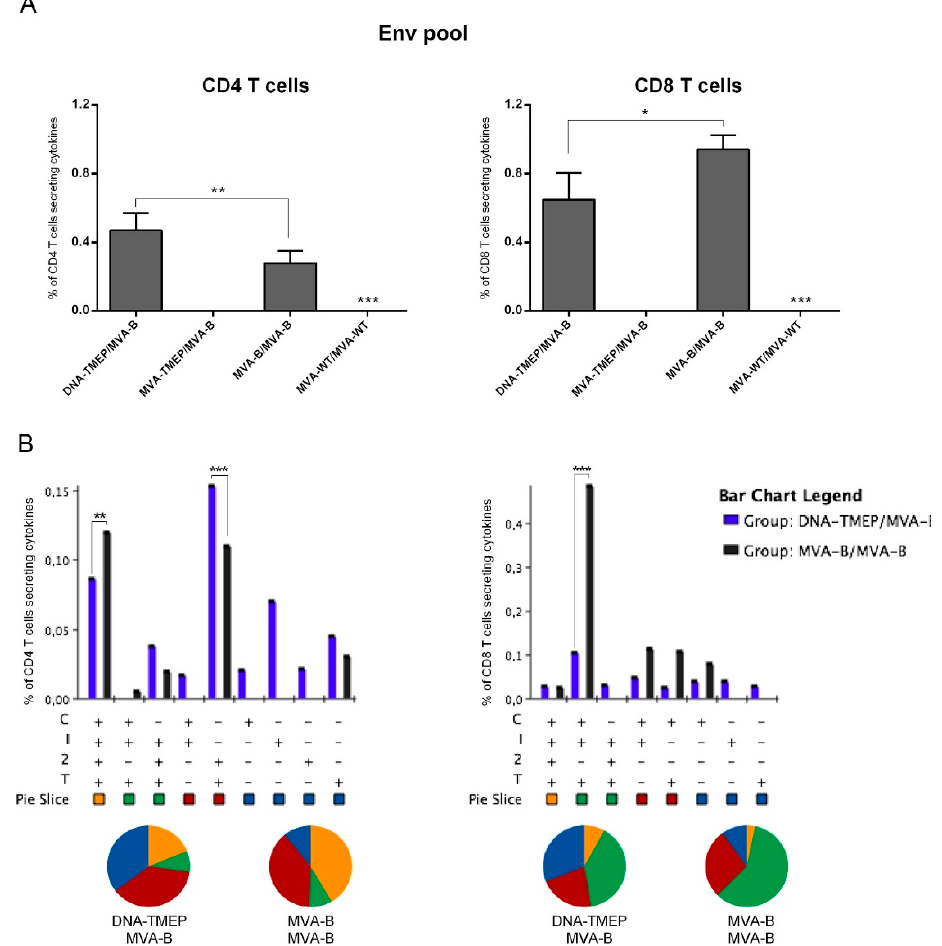
Figure 5. Polyfunctional Env-specific CD4 and CD8 T cell responses induced in spleen after prime / boost immunization of mice with the MVA-B vector. ( A ) Magnitude of the Env-specific CD4 (left panel) or CD8 (right panel) T cell responses determined at 10 days post-boost by ICS assay after the stimulation of the splenocytes from immunized mice with the HIV-1 clade B consensus Env pool. The total value in each group represents the sum of the percentages of CD4 + or CD8 + T cells secreting IFN- γ and / or IL-2 and / or TNF and / or expressing CD107a against the HIV-1 Env pool. Data are background-subtracted. ( B ) Polyfunctional profile of the Env-specific CD4 (left panel) or CD8 (right panel) T cell responses. The percentages of the functionally distinct cell populations within the total CD4 or CD8 T cells are represented on the y axis, while positive combinations of the responses are represented on the x axis. Responses are grouped and color-coded based on the number of functions. C: CD107a; I: IFN- γ ;